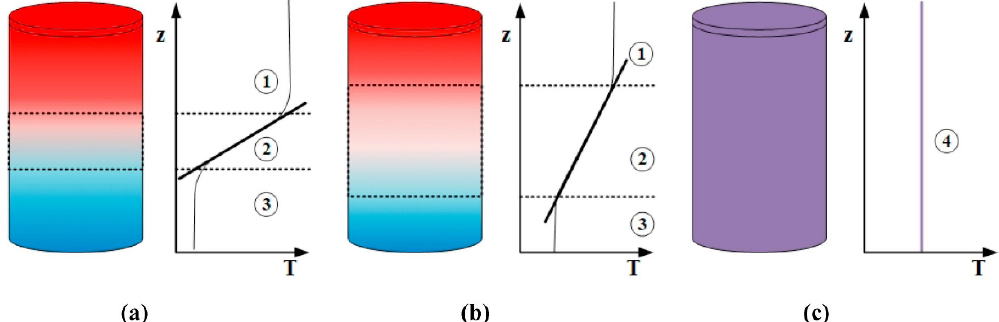
Figure 2. Different levels of stratification in thermocline TES tank [9]. ( a ) Highly stratified; ( b ) moderately stratified; ( c ) fully mixed storage. (1) Hot region; (2) thermocline region; (3) cold region; (4) uniform temperature. Reprinted with permission from ref. [9]. 4 October 2021, Elsevier.